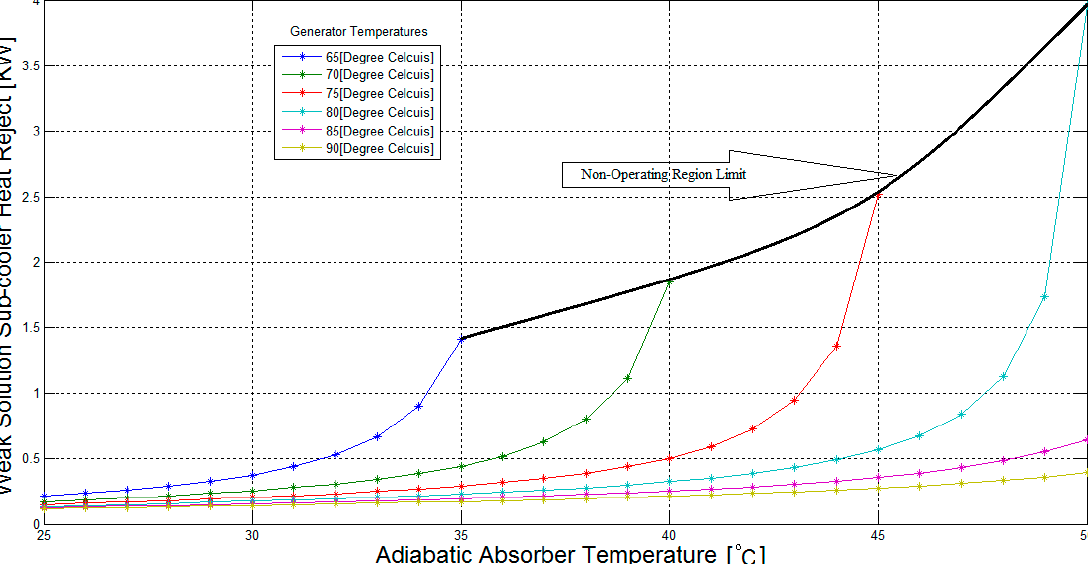
Figure 7. Graph showing the variation of the heat rejection in the weak solution sub-cooler, with generator temperature and adiabatic absorber temperature ( T con = 35 ◦ C, T eva = 10 ◦ C ) .